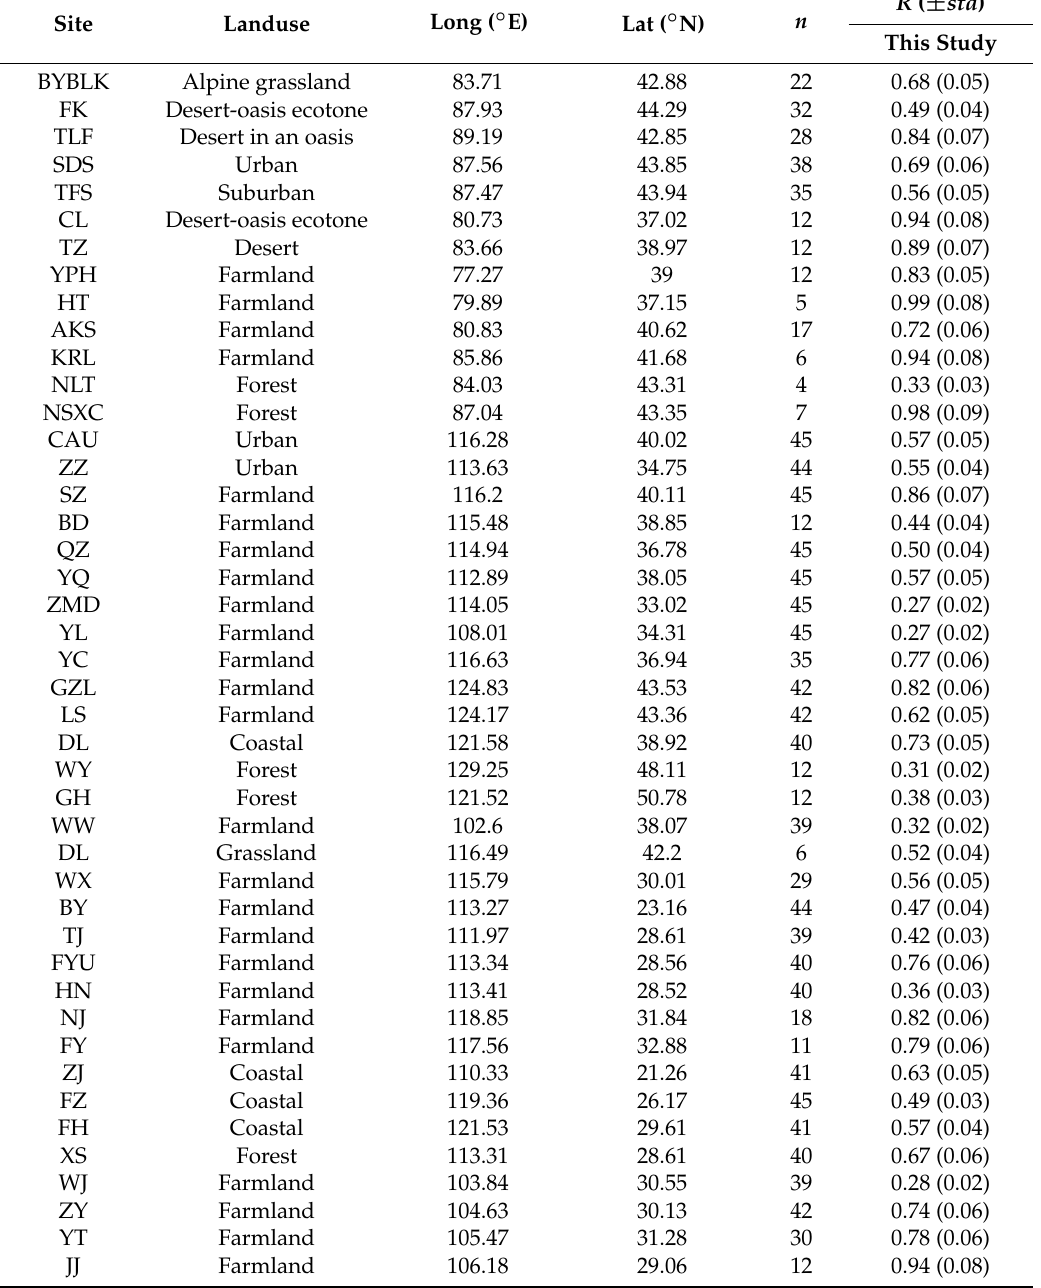
Table A2. Comparison between monthly IASI satellite-derived ground NH 3 concentrations and the NNDMN monitoring sites from 2010 to